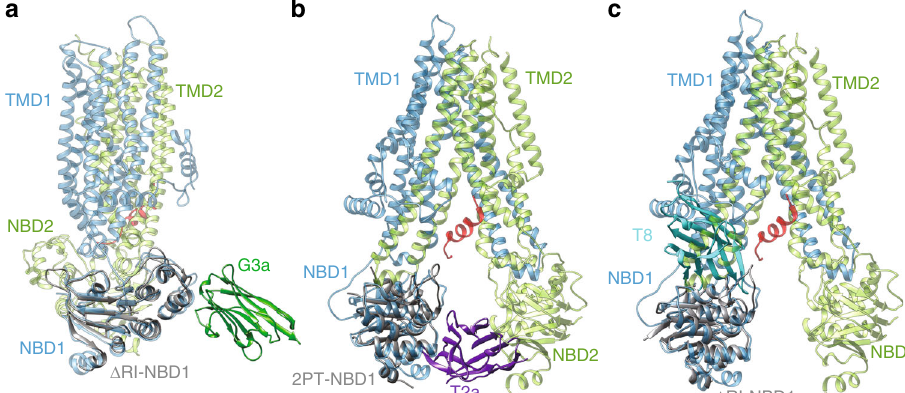
Fig. 6 NBD1-nanobody complexes superimposed onto the structure of CFTR. a The previously reported cryo-EM structure of CFTR (PDB: 5UAK) was aligned with structure of Δ RI-NBD1-G3a complex showing that the epitope is located in the periphery of CFTR. b Same alignment as ( a ) with the structure 2PT-NBD1-T2a complex, showing a compatible binding of nanobody D12 in between the NBDs. c Same alignment as ( a ) with the Δ RI-NBD1-T8 complex where the nanobody overlaps with the TMDs, indicating that binding is not compatible with this conformational state of CFTR